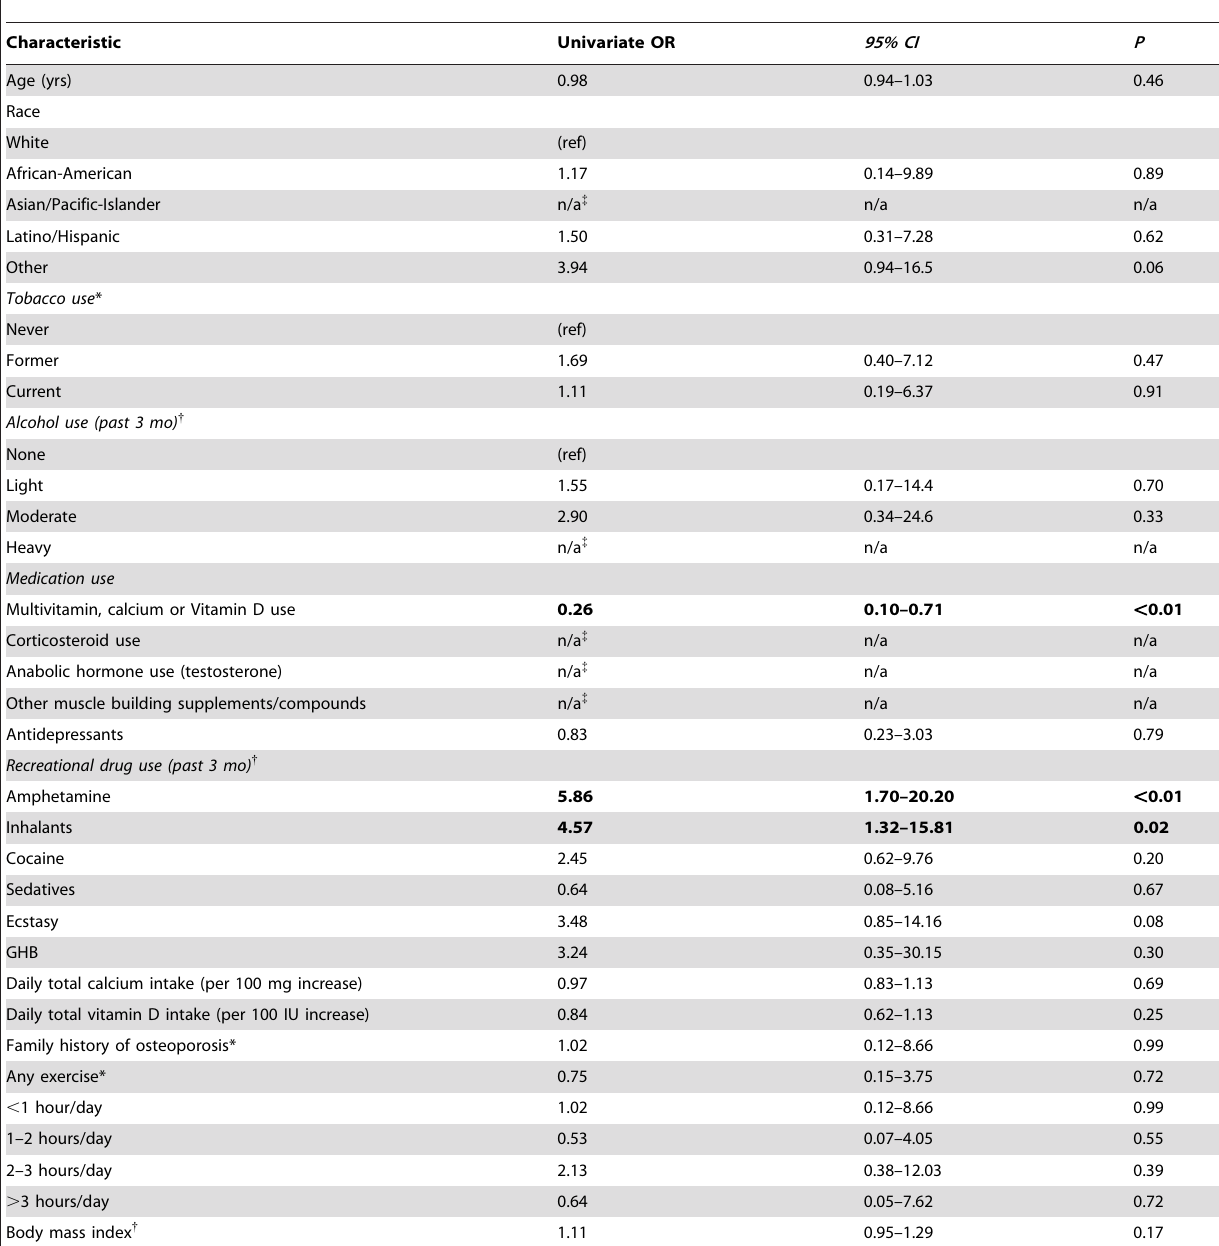
Table 2. Selected Parameters Associated with Low Bone Mineral Density (Z score #2